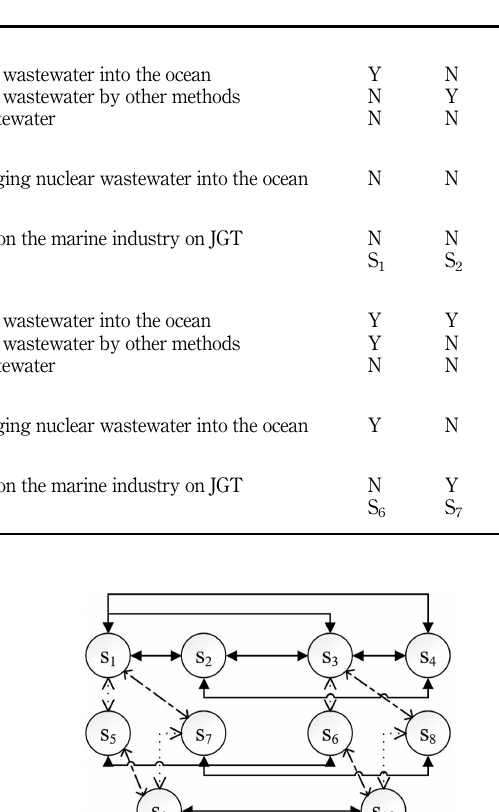
Figure 3. The integrated graph for the conflict of discharging of nuclear